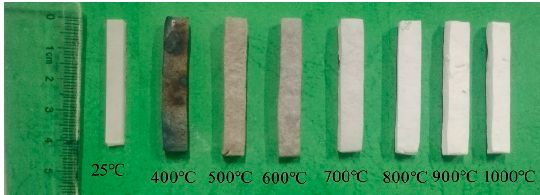
Figure 10. The appearance of sintered samples at different sintering temperatures.